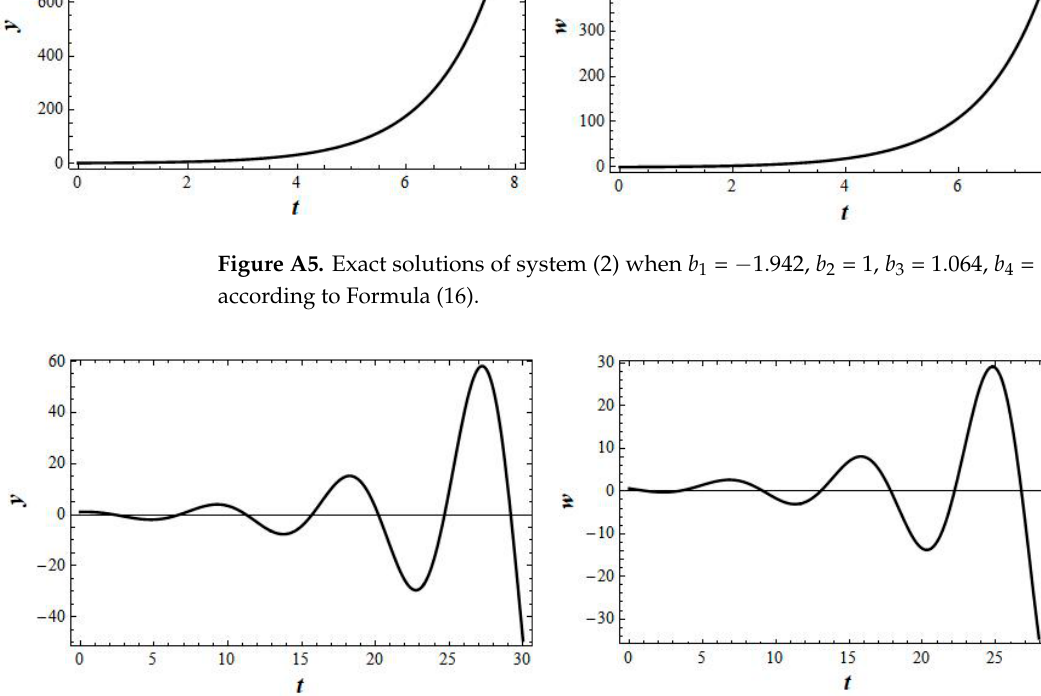
Figure A6. Exact solutions of system (2) when b 1 = 3, b 2 = 1, b 3 = 2, b 4 = − 1, k = − 0.75, c 2 = 1, c 3 = 0, ac ‐ cording to Formulas (18) and (23)–(25).